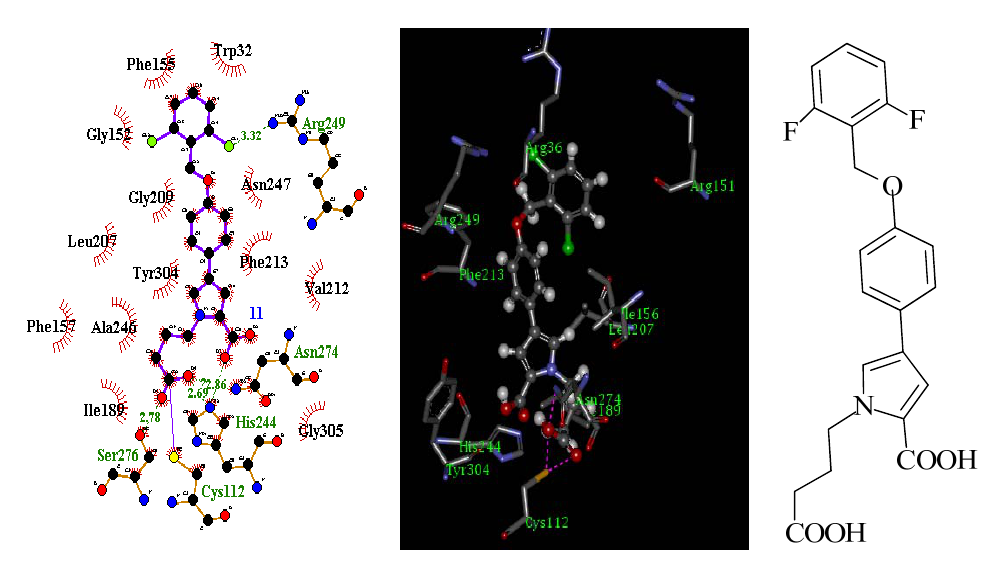
Figure 1. Predicted binding model of compound 7d in the active site tunnel of mt